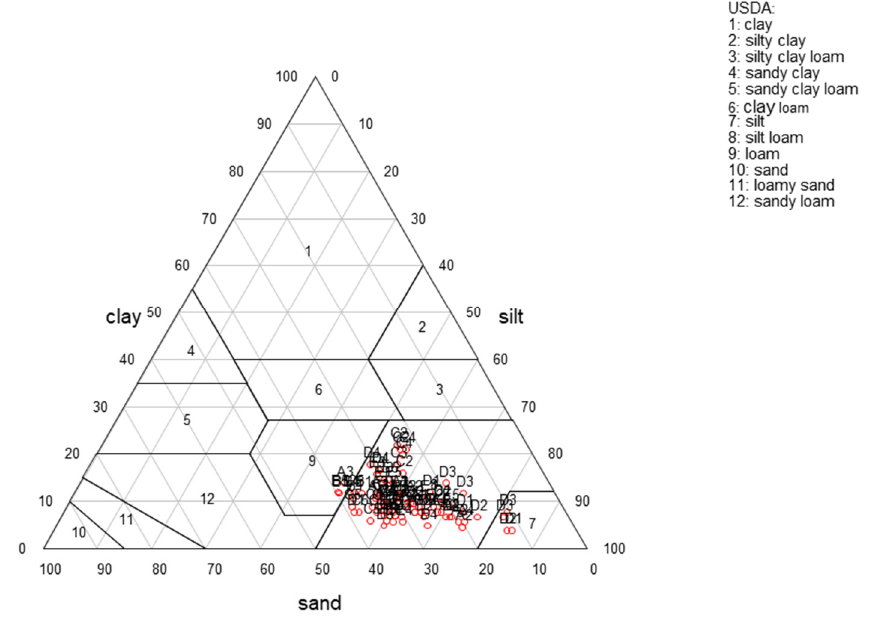
Figure 4. The soil textural triangle indicating the soil textures of sampled plots of different farming practices.